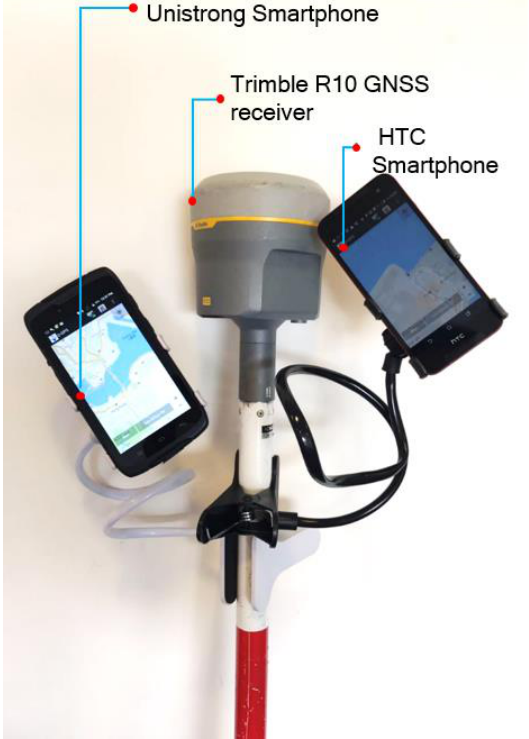
Figure 3. Experimental